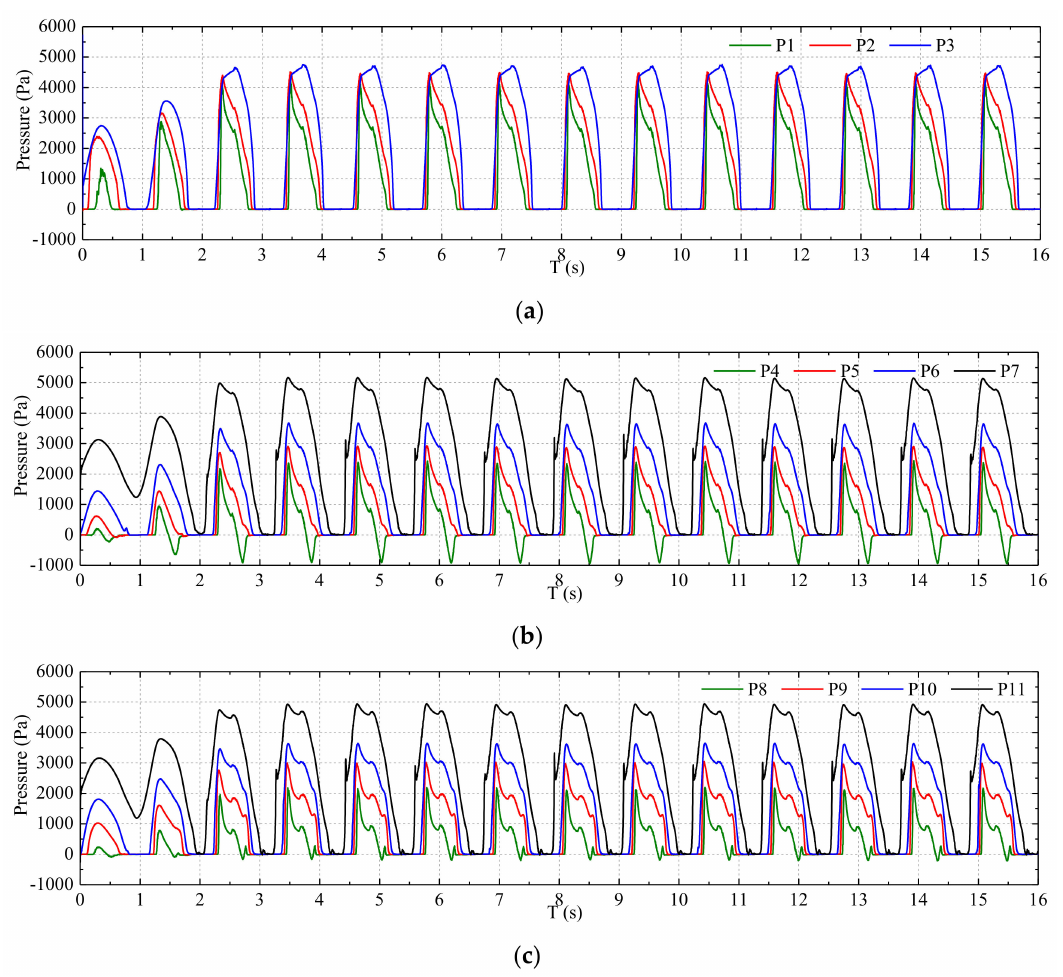
Figure 26. Impact pressure for the case of ship sail in symmetric wave field: ( a ) sensors at centerline of bow; ( b ) sensors at cross-section of #19.5 station; ( c ) sensors at cross-section of #19